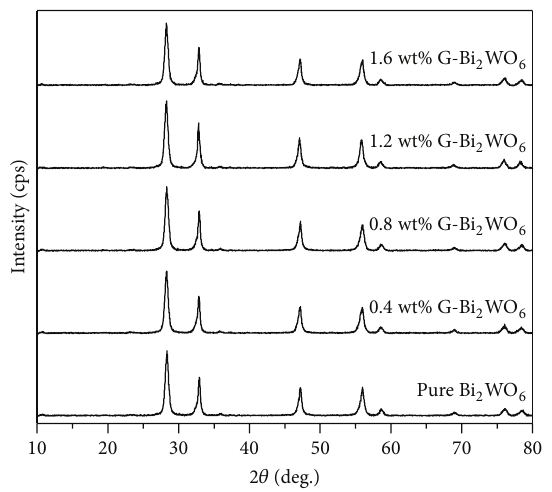
Figure 1: XRD patterns of pure Bi 2 WO 6 and G-BWO composites.